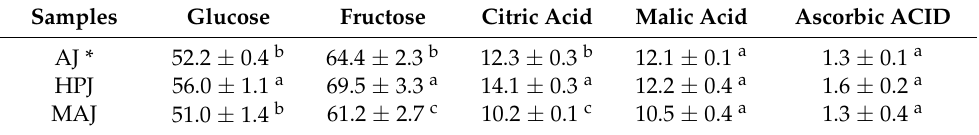
Table 2. Sugars and organic acids (g L − 1 ) found in the pomegranate juice samples. Samples Glucose